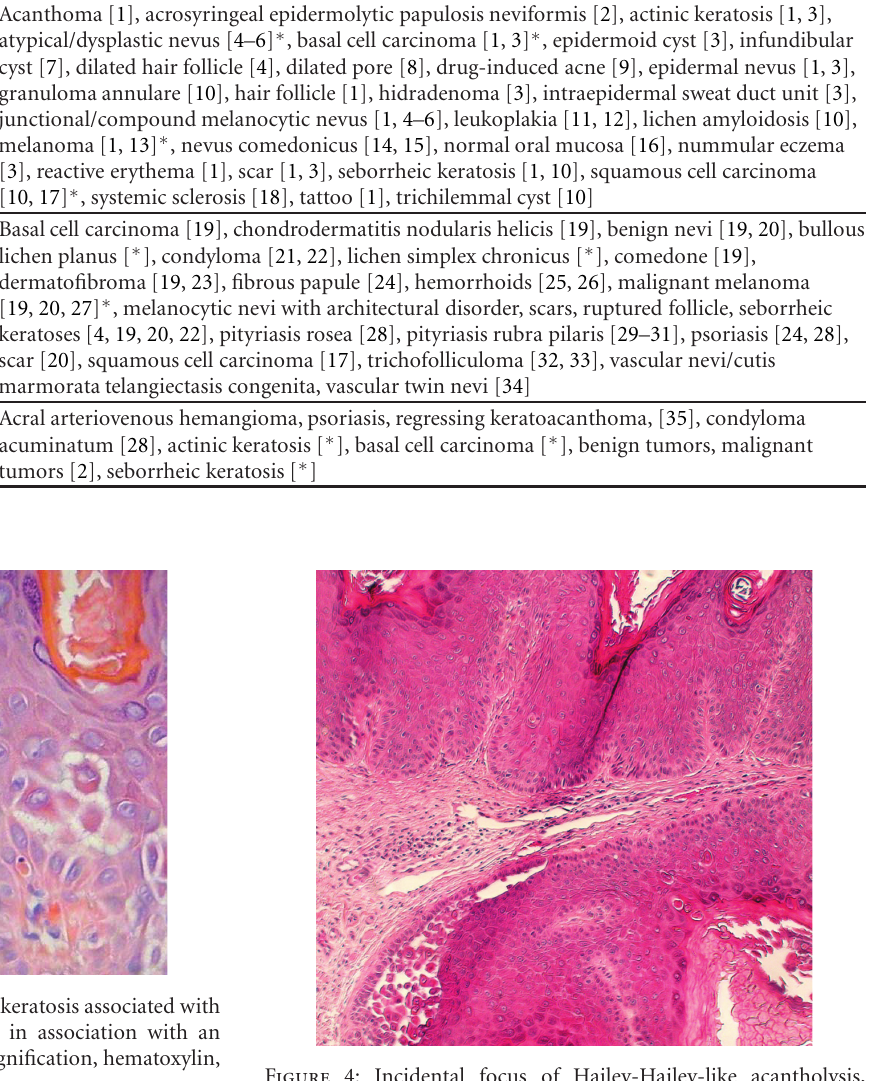
occurring in association with a benign keratosis with features of seborrheic keratosis. (200X magnification, hematoxylin, and eosin